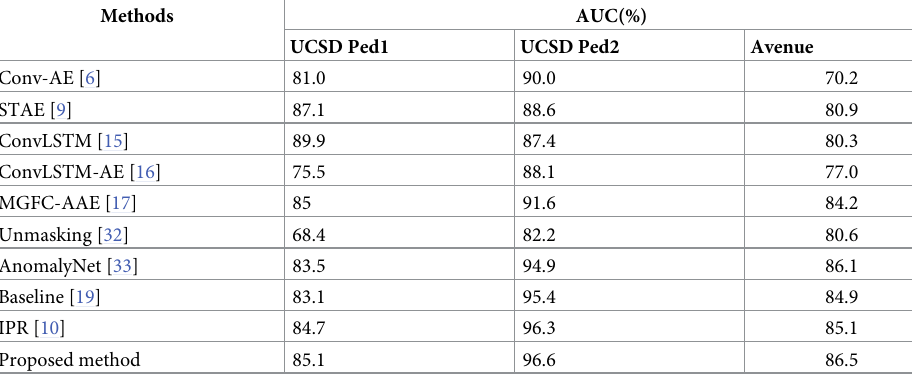
Table 1. Comparison of frame-level AUC values on different datasets.